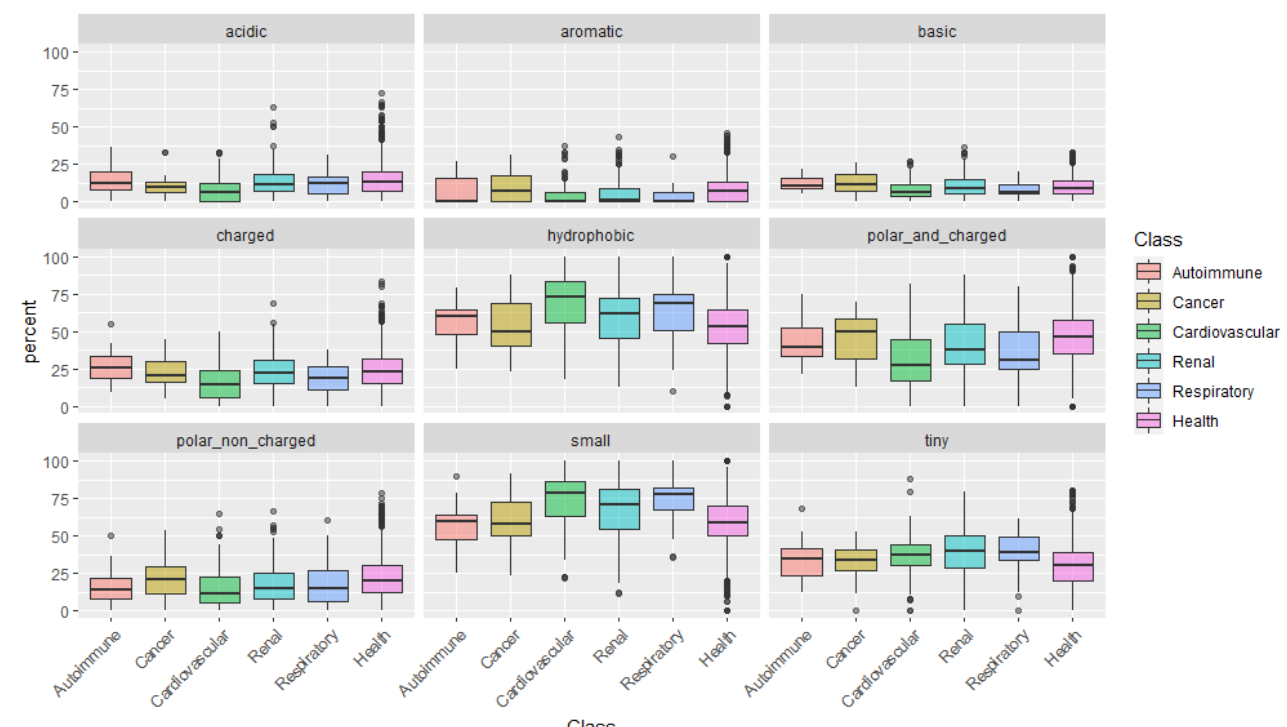
Figure 3. Composition of amino acid groups, according to physical-chemical properties (size, hydrophilicity/hydrophobicity, and isoelectric point) across the five main disease classes.